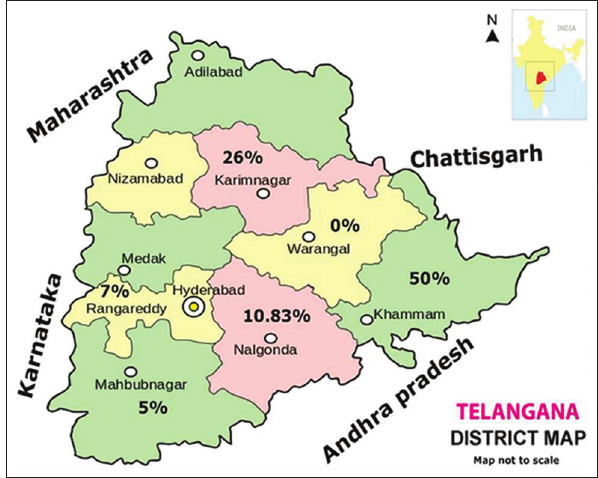
Figure-1: Overall seroprevalence of bluetongue in different districts of Telangana. Seroprevalence was studied in six districts of Telangana state: Karimnagar, Warangal, Khammam, Nalgonda, Mahabubnagar, and Ranga Reddy. Overall seroprevalence in each district was indicated as percentages in the map [Source: https://www.uokpl.rs/